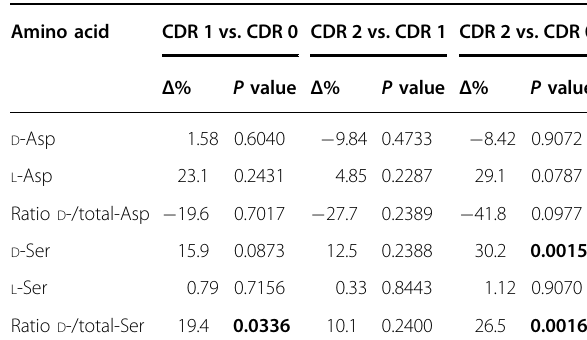
Table 2 Statistical analysis of the levels of aspartate and serine enantiomers, D -/total-Asp and D -/total-Ser ratios observed in serum of HS and AD patients.